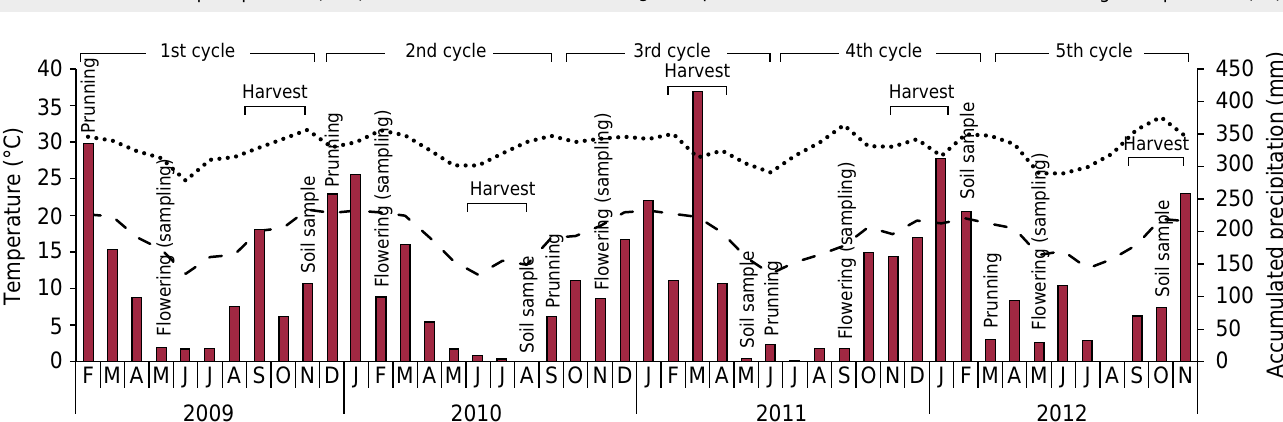
Figure 1. Climate Data at the Citriculture Experimental Station (2009-2012), Bebedouro, SP, Brazil; physiological and research aspects.